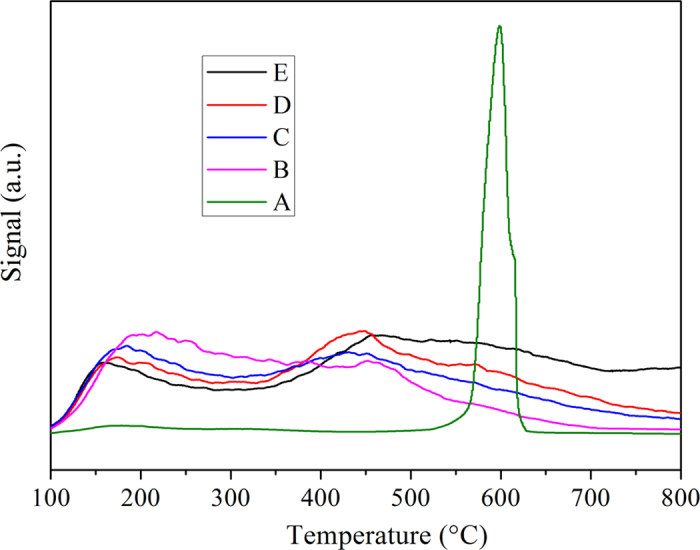
NH3-TPD profiles of (A) pure PTA, (B) synthetic Al2O3 support, (C) Ni-PTA(10)/Al2O3 catalyst, (D) Ni-PTA(30)/Al2O3 catalyst and (E) Ni-PTA(50)/Al2O3 catalyst.